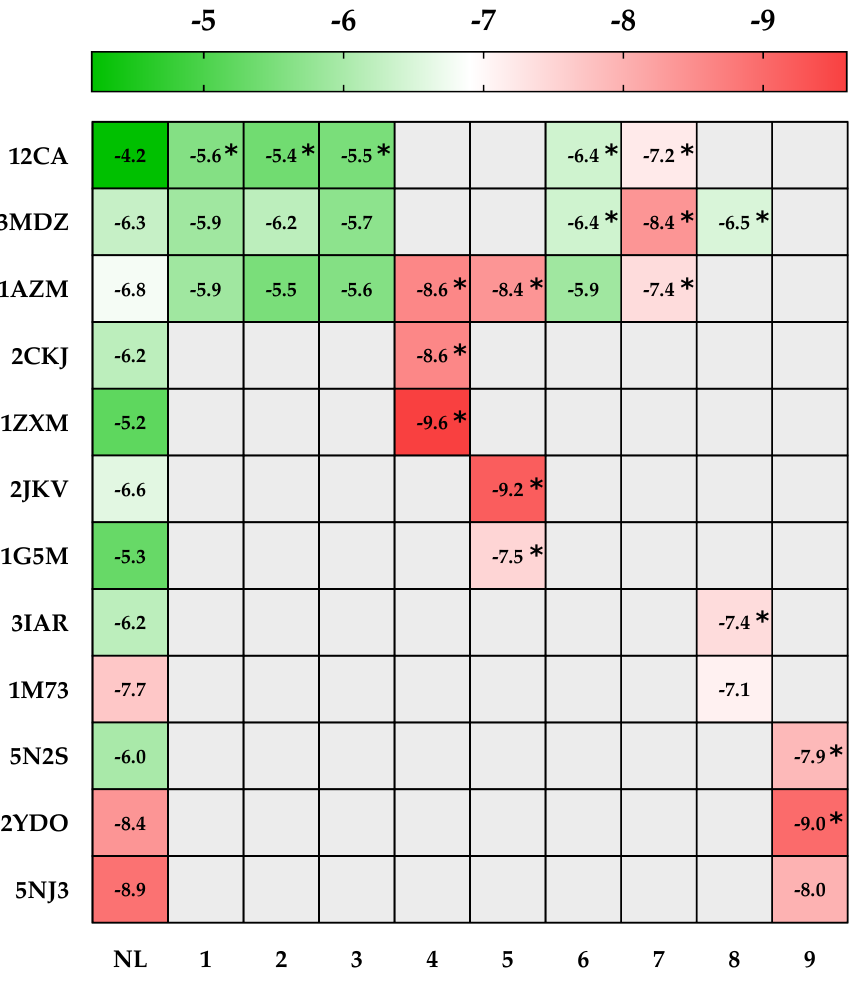
Figure 4. Heat map of the binding free energy values (expressed in kcal/mol) of A. halimus ethanolic extract phytoconstituents. Left axis shows the predicted targets (see Section 3.4.2). ( 1 ) Gallic acid, ( 2 ) syringic acid, ( 3 ) trans -ferulic acid, ( 4 ) myricetin, ( 5 ) catechin gallate, ( 6 ) caffeic acid, ( 7 ) chlorogenic acid, ( 8 ) arbutin, ( 9 ) trimethoxyflavone. NL refers to the native ligands (Section 3.4.2). Ligands with a docking score lower or equal to the native ligand’s score were highlighted with a star (*).